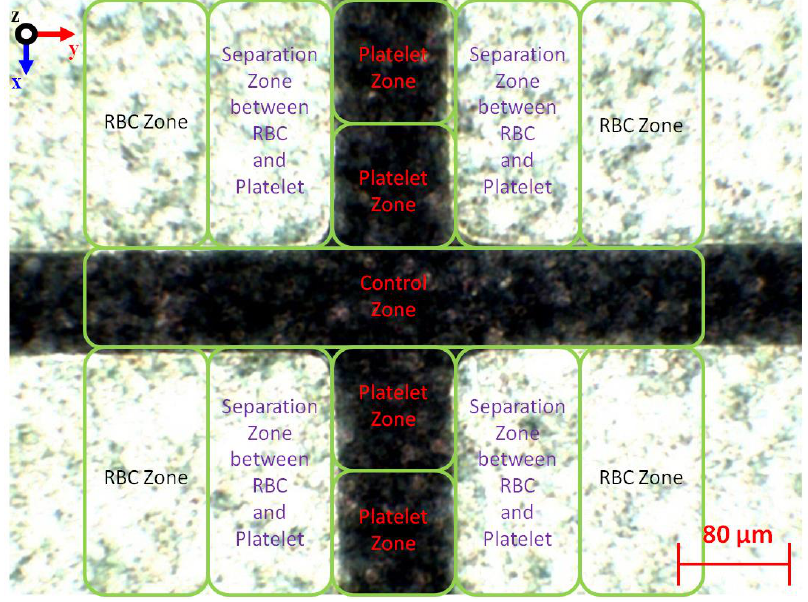
Figure 11. The separation, RBC and platelet zones.